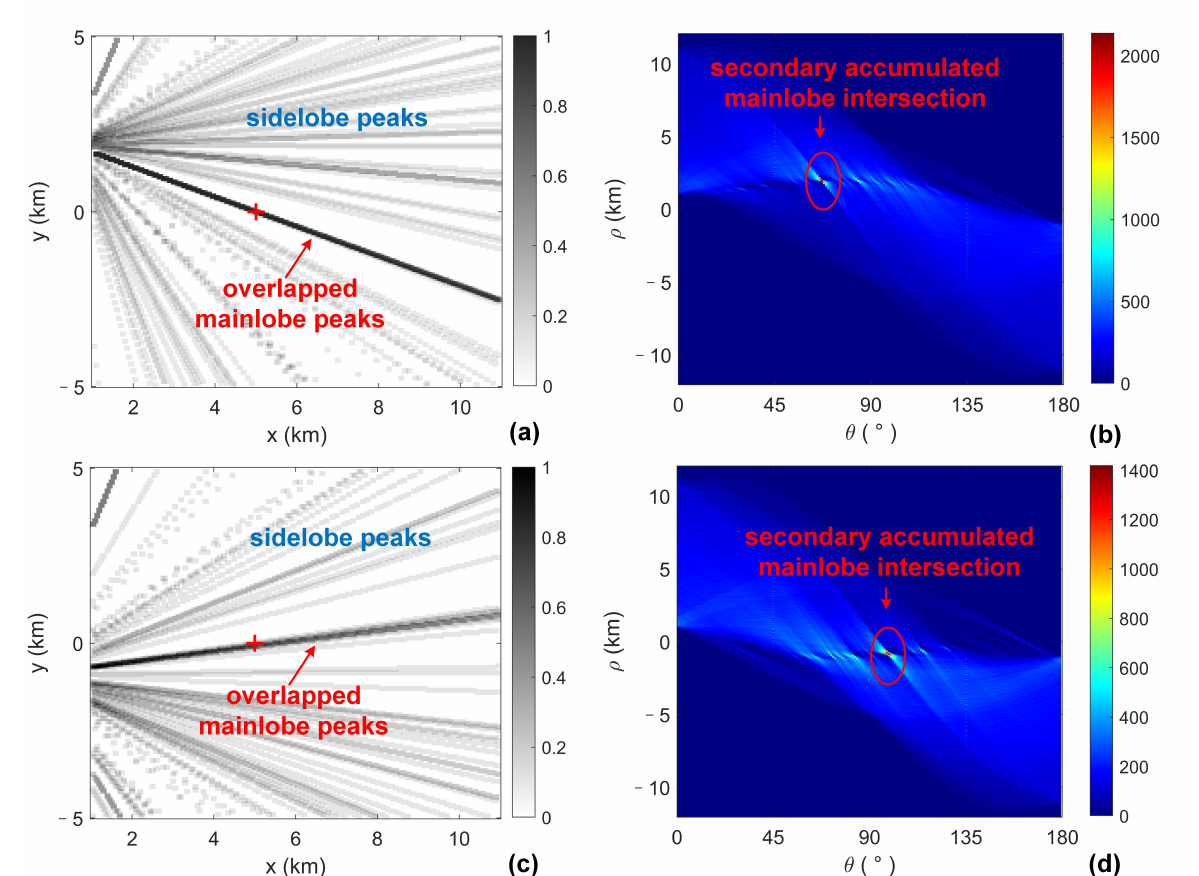
Figure 5. (Color online) ( a , c ) Wideband Peak Distribution (PD) patterns of array 1 and 3; ( b , d ) The secondary accumulating matrices of array 1 and 3. The red plus markers indicate the true position of the